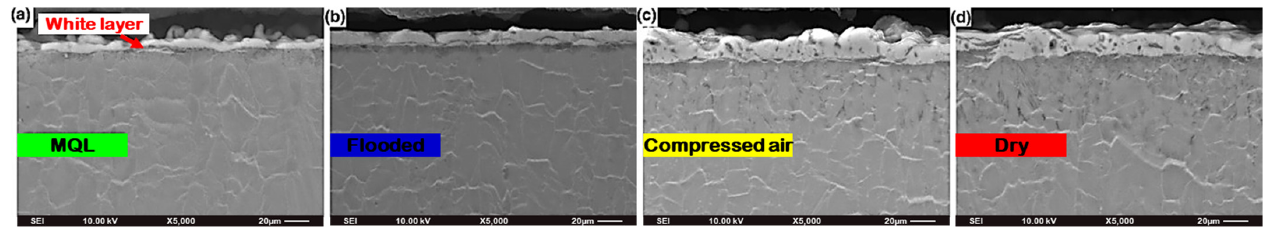
Figure 16. SEM images illustrating the effect of cutting environments on white layer thickness of machined surfaces at f = 0.16 mm/rev, v = 111 m/min for: ( a ) MQL; ( b ) flooded; ( c ) Compressed air; ( d ) Dry.